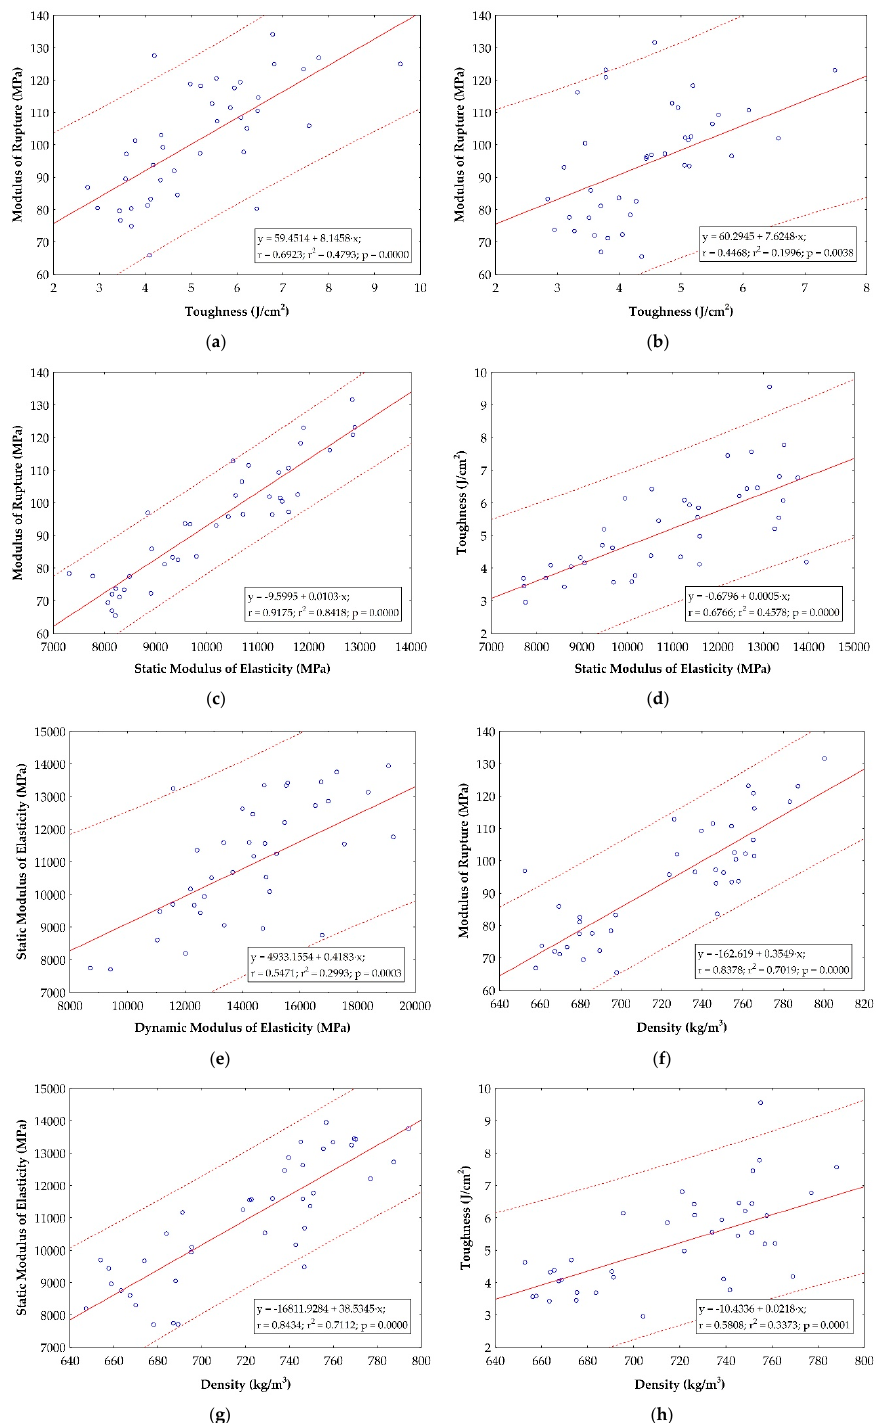
Figure 11. For oak wood is shown the relationship between: modulus of rupture and toughness in radial direction ( a ), modulus of rupture and toughness in tangential direction ( b ), modulus of rupture and static modulus of elasticity in tangential direction ( c ), toughness and static modulus of elasticity in radial direction ( d ), static modulus of elasticity and dynamic modulus of elasticity in radial direction ( e ), modulus of rupture and density in tangential direction ( f ), static modulus of elasticity and density in radial direction ( g ), toughness and density in radial direction ( h ).